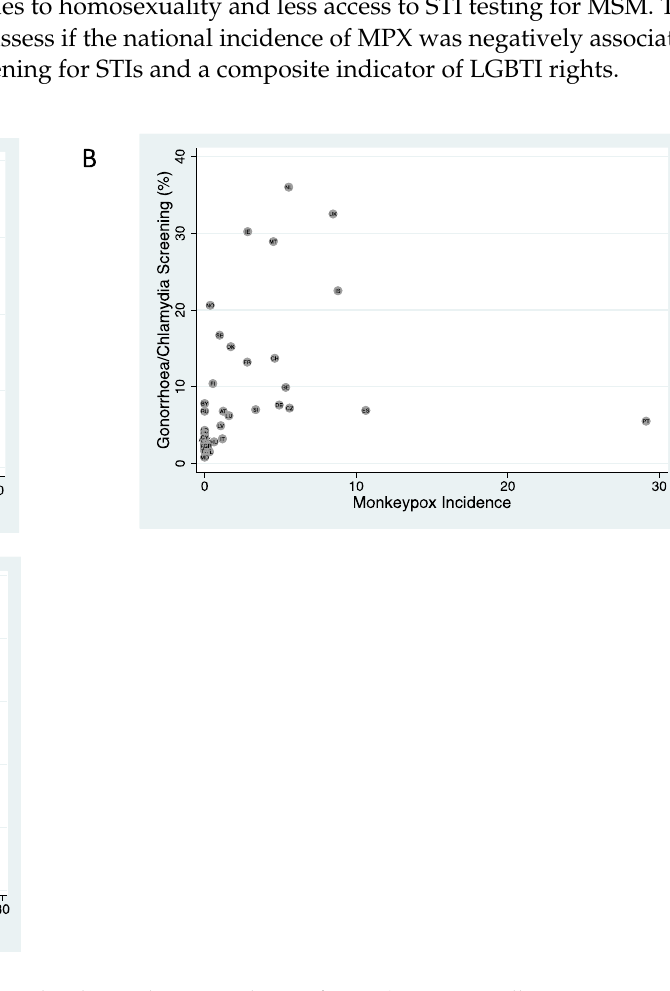
UA = Ukraine, UK = United